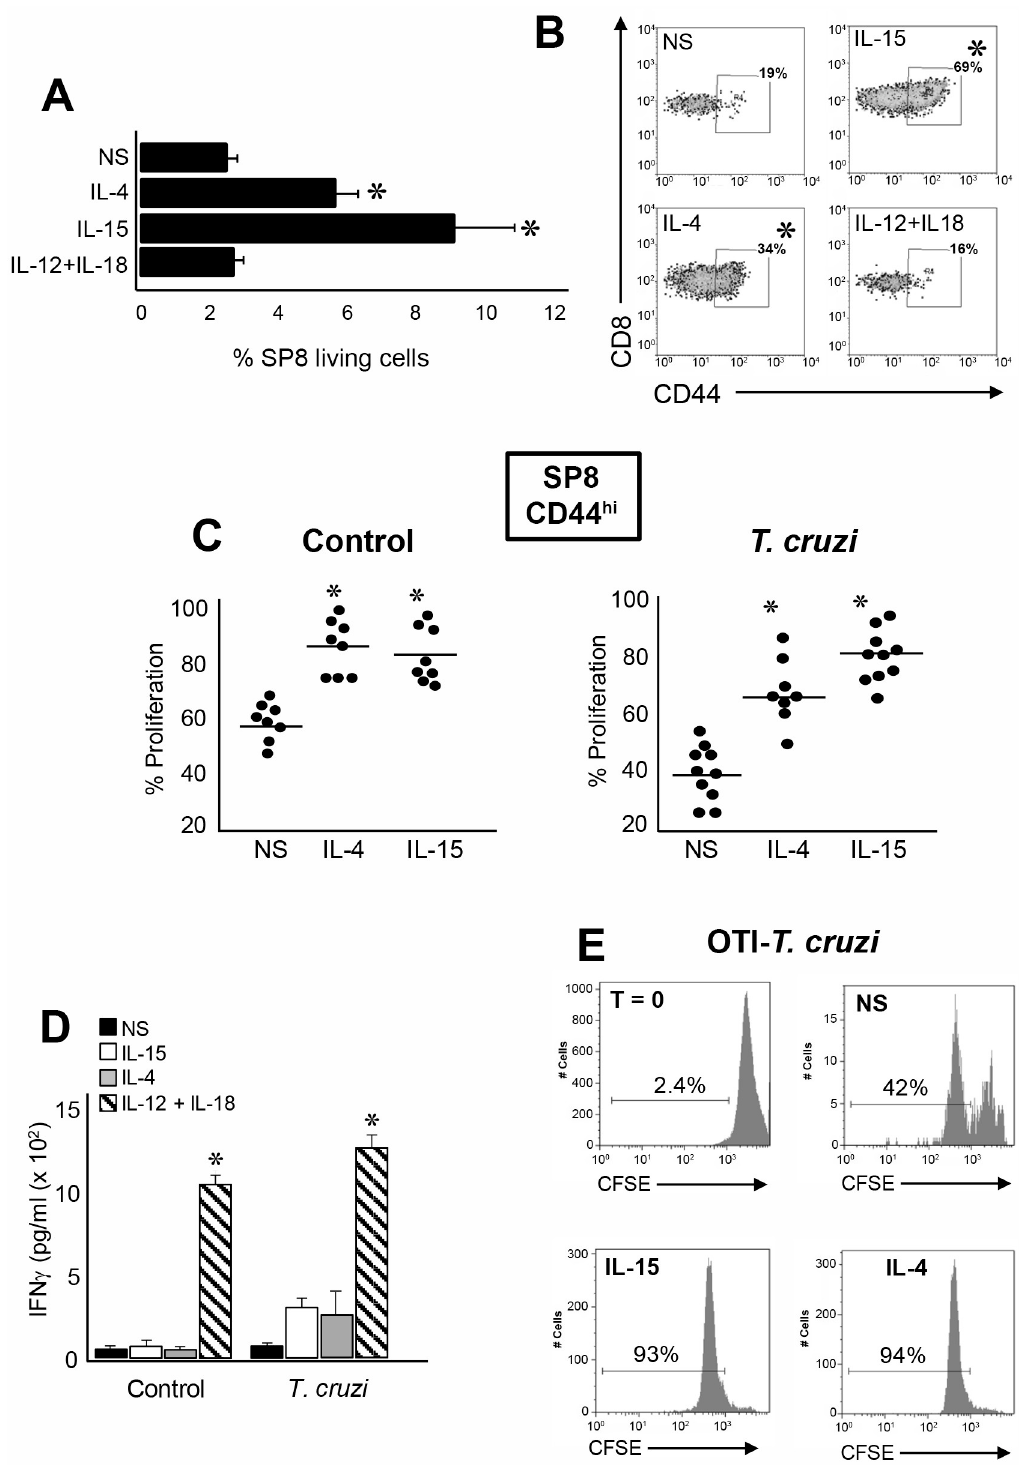
Fig 6. Preferential expansion/selection of innate CD8 + thymocytes in the thymus of T . cruzi -infected mice. Thymocytes from T . cruzi -infected (Tulahuen) WT mice were cultured with 150 ng/ml of rIL-15, 20 ng/ml of rIL-4 or 10 ng/ml of rIL-12 plus 50 ng/ml of rIL-18. After 72h of culture cells were harvested and Flow cytometry analysis was performed. The percentage of (A) SP8 cells in the living gate of total thymocytes or (B) SP8 CD44 hi thymocytes were calculated. In (A) data was expressed as